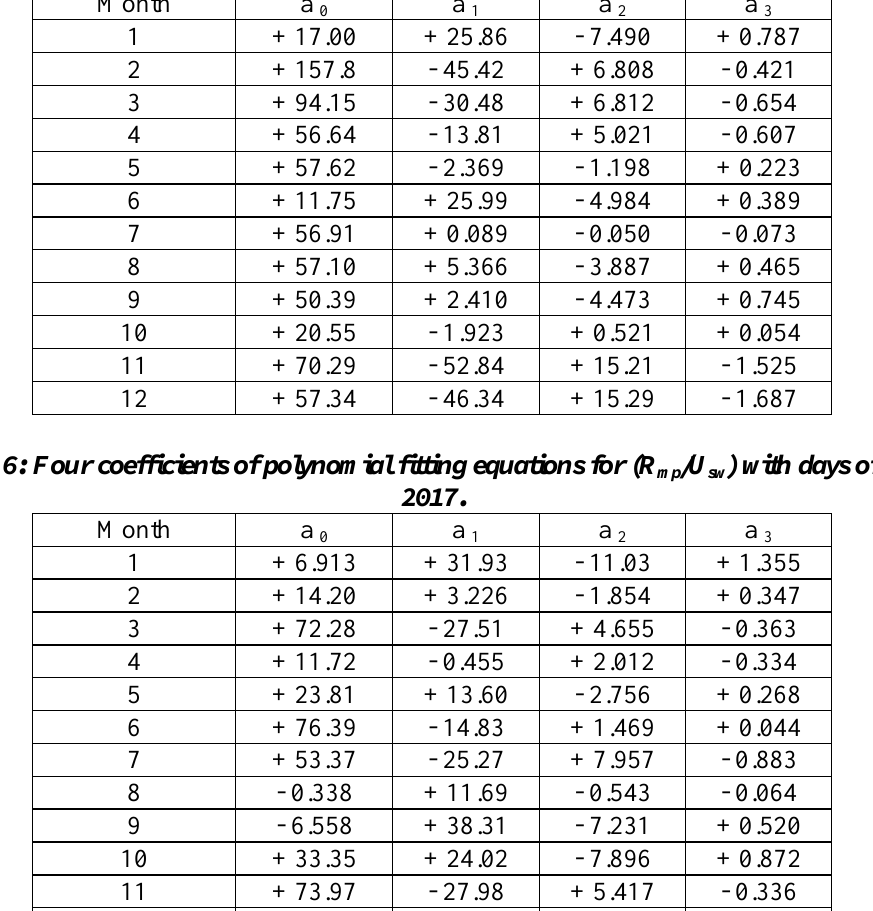
/U ) with days of year mp sw